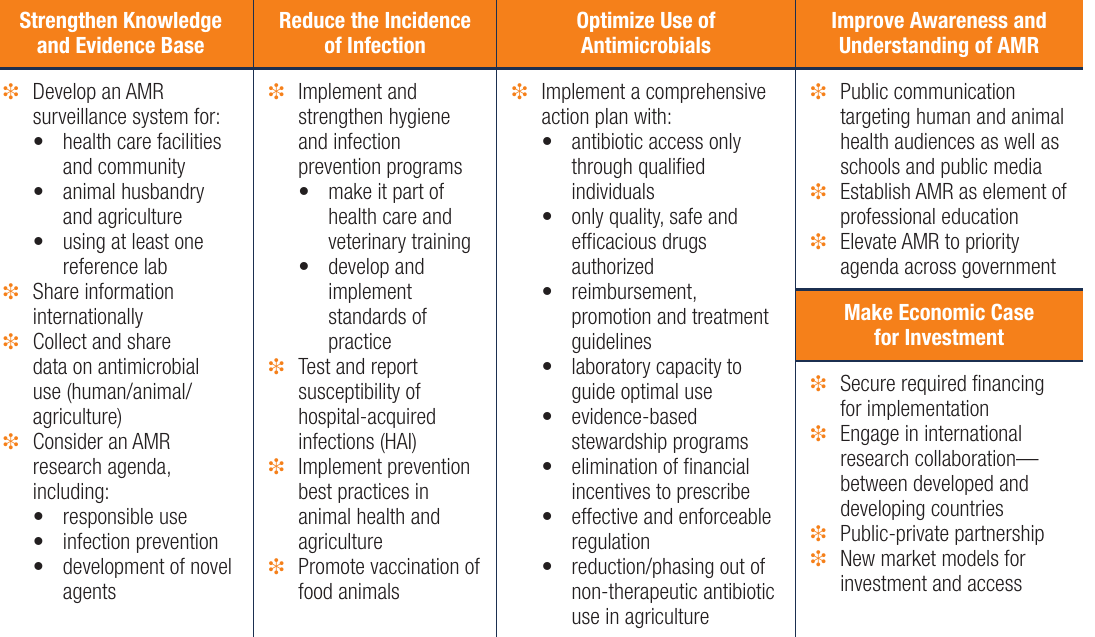
FIGURE 8. The Five Objectives of the WHO Global Action Plan on AMR,